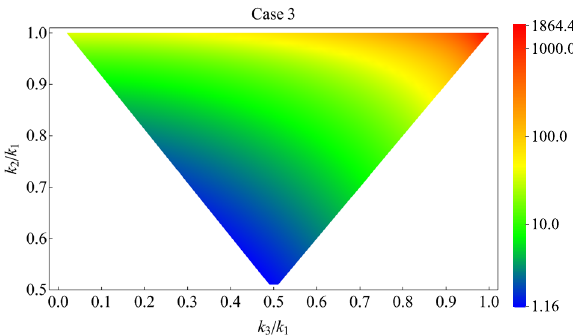
Fig. 5 The equilateral non-Gaussianity parameter f equil Cases 1, 2, and 3